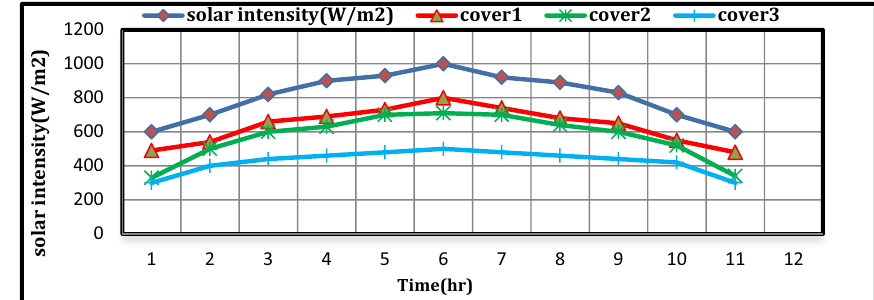
Figure 4: Solar intensity green - house